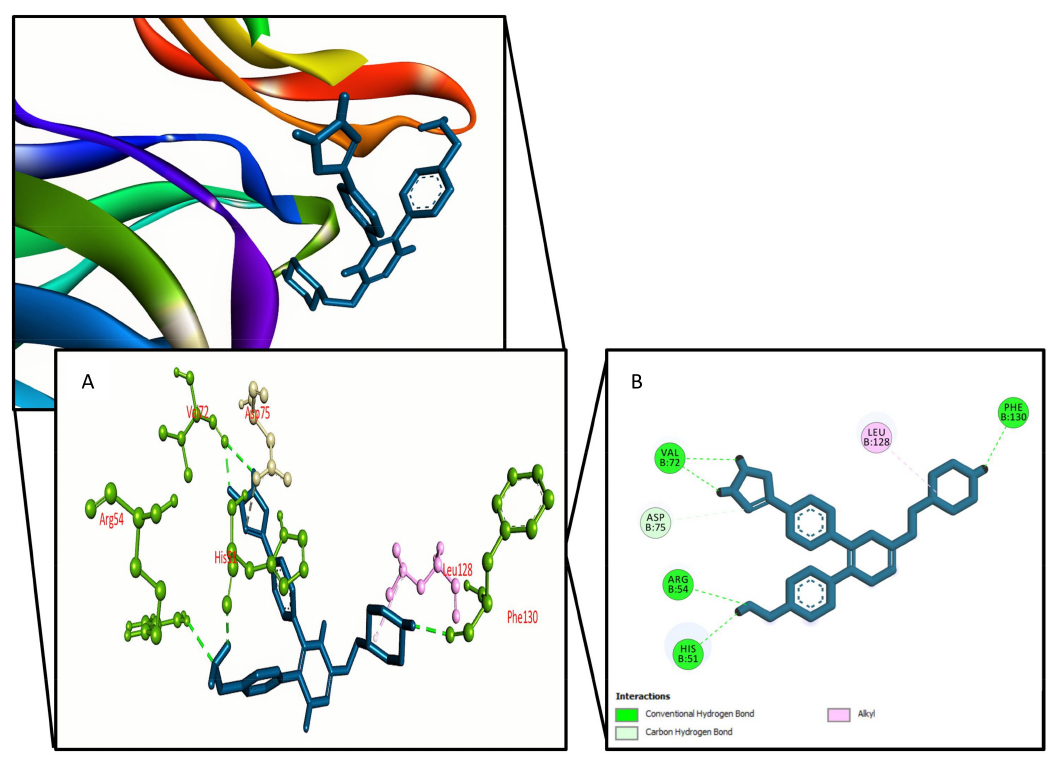
Figure 4. The control ligands binding interactions with the Dengue virus NS2B/NS3 protease, ( A ) 3D representation and ( B ) 2D